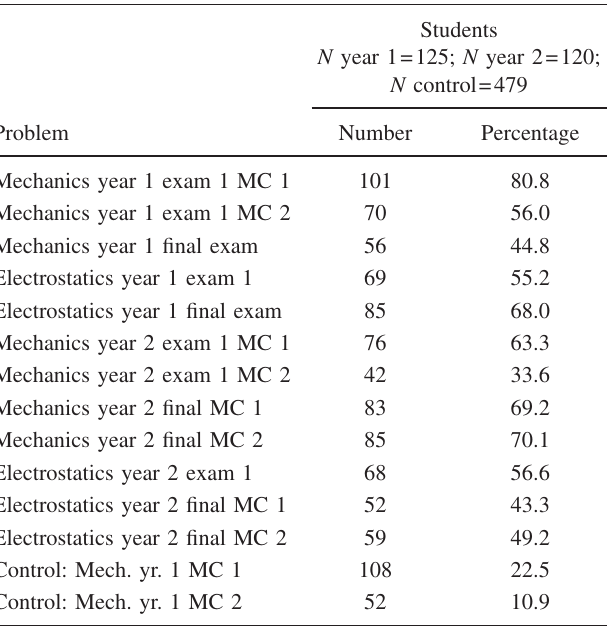
TABLE III. Number of students who drew FBDs to help solve exam